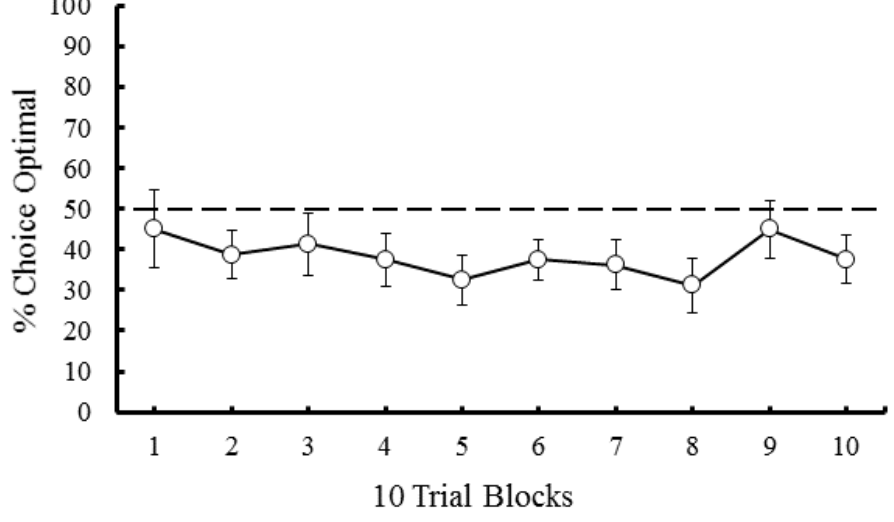
Figure 2 . Pigeons’ performance on the automated (operant) chamber ephemeral reward task (error bars = ±SEM; after Zentall et al., 2016, Experiment 2).